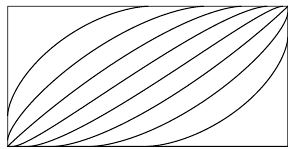
Figure 1.3: The limit curves in a d × 2 d rectangle (created by Dan Romik, April